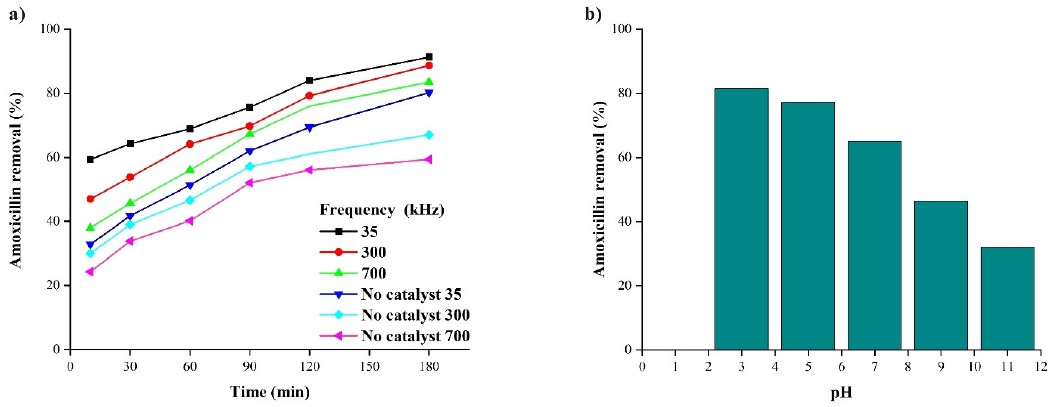
Fig. 2. a. Effect of ultrasonic frequency b. Effect of pH on amoxicillin